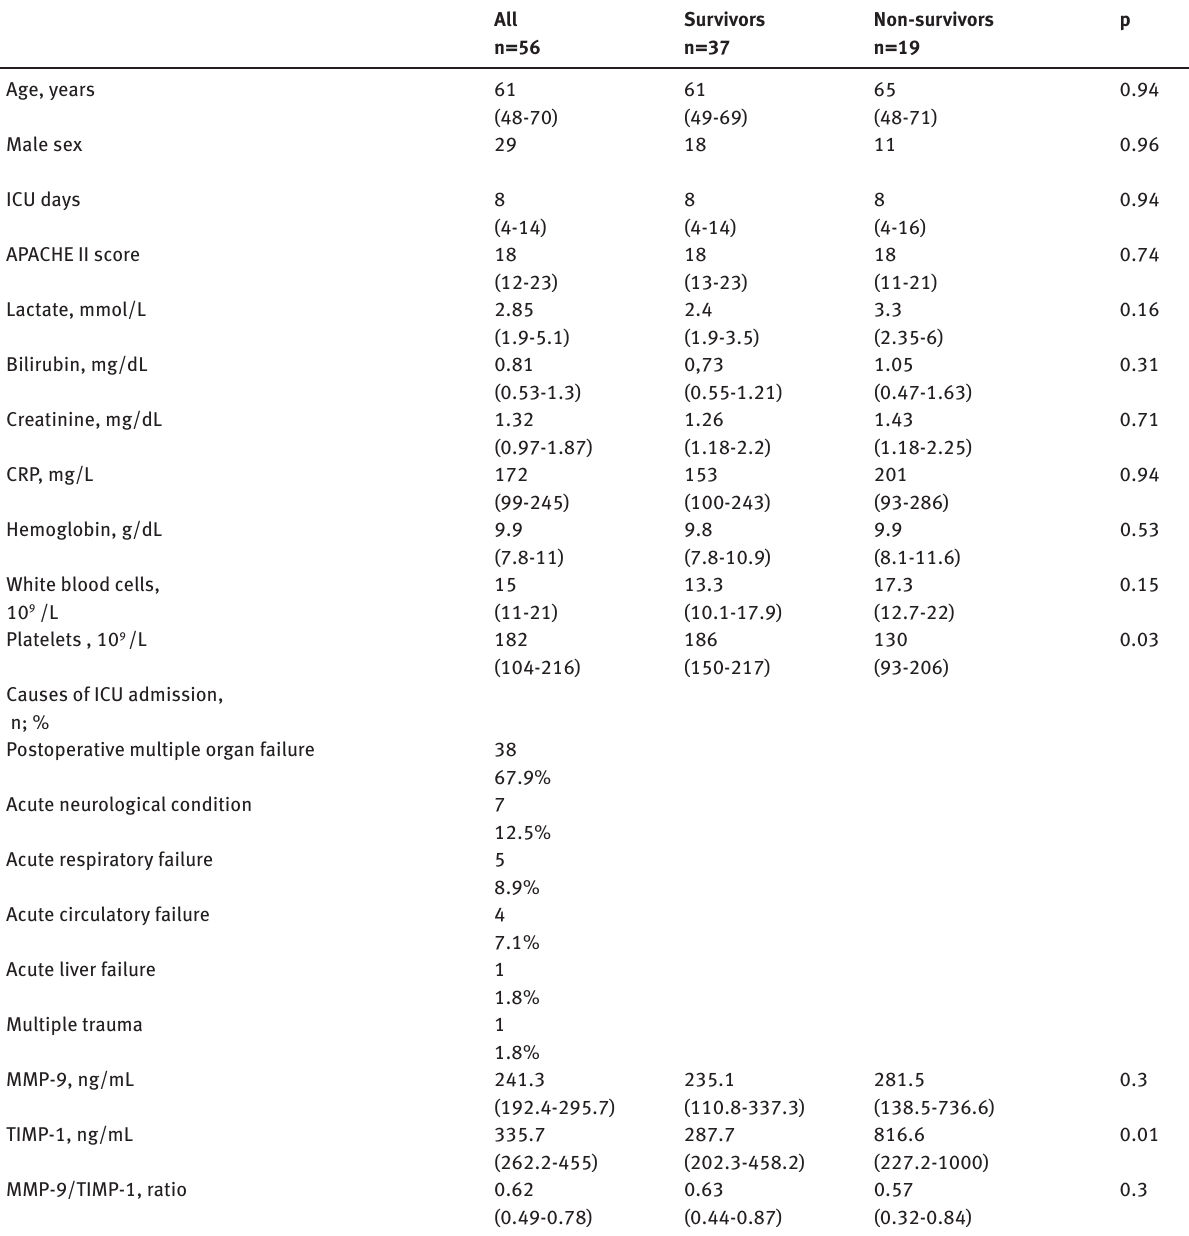
Table 1: Baseline clinical and biochemical characteristics of ICU survivors and non-survivors patients on day 1 of